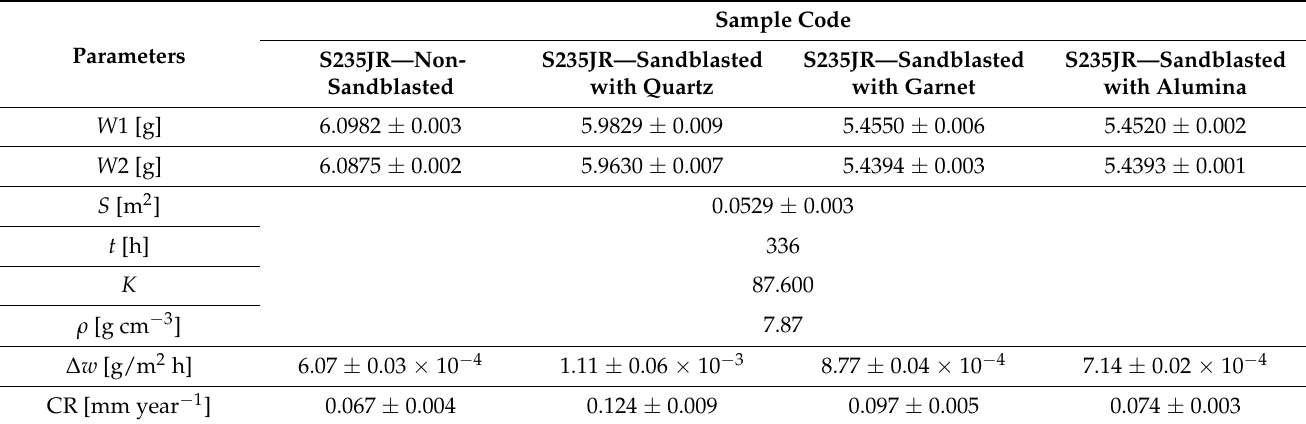
Table 4. The weight loss of the S235JR steel samples for S235JR—non-sandblasted, S235JR—sandblasted with quartz, S235JR—sandblasted with garnet, and S235JR—sandblasted with alumina during 336 h from immersion